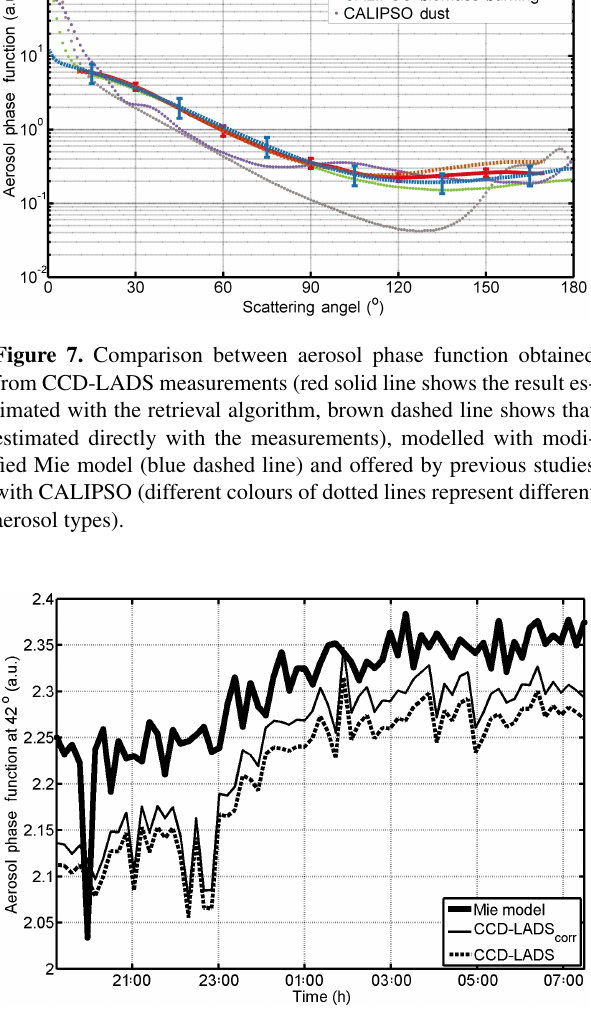
Figure 8. Comparison between aerosol phase function at 42 ◦ scat- tering angle obtained from CCD-LADS measurements (results es- timated with the retrieval algorithm are shown with a fine solid line, while the values estimated directly with the measurements are shown with a dashed line) and modelled with a modified Mie model (shown with a bold solid